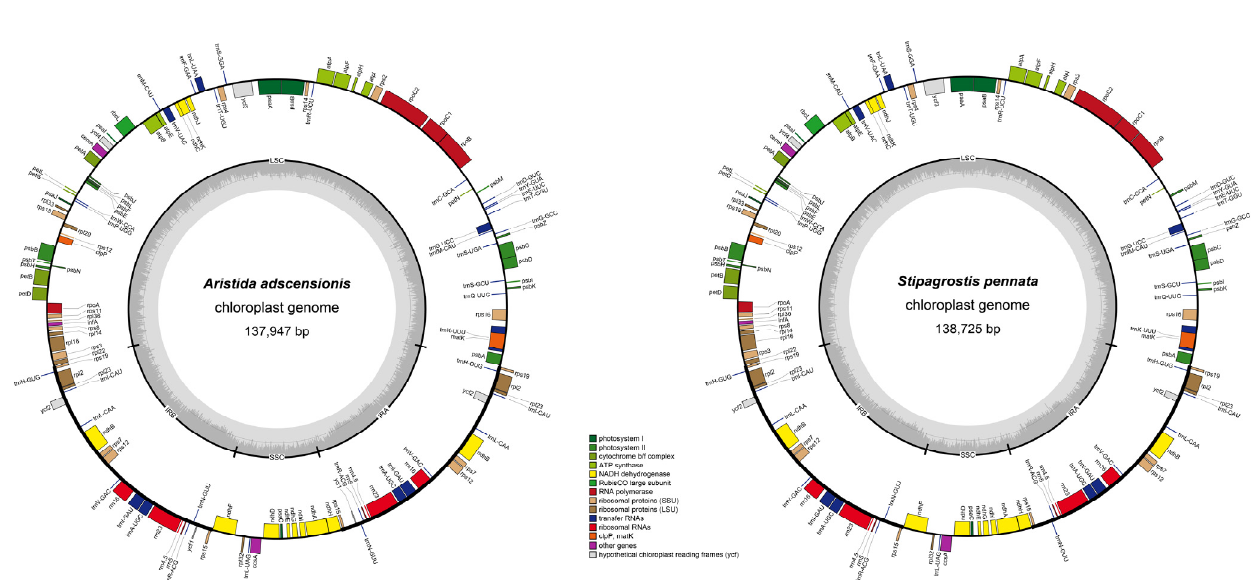
Figure 1. Maps of the newly sequenced plastome of Aristida adscensionis and Stipagrostis pennata . Different color blocks on the outer ring represent genes with different functions. The genes outside the outer ring were transcribed in a counterclockwise direction, while the genes inside the outer ring were transcribed in a clockwise direction. The gray dotted area in the inner circle represents the GC content of the plastomes.